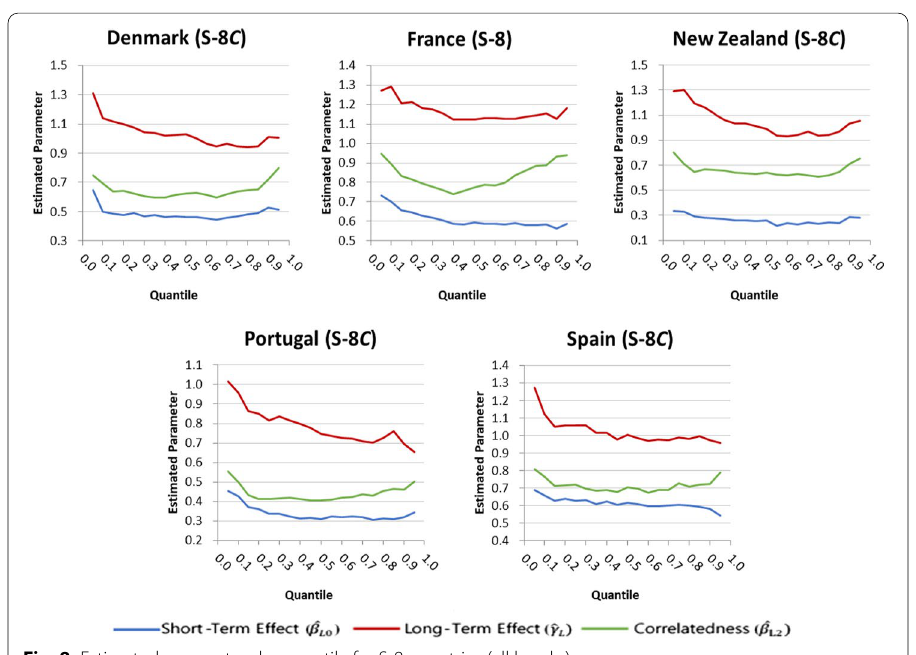
Fig. 8 Estimated parameters by quantile for S-8 countries (all